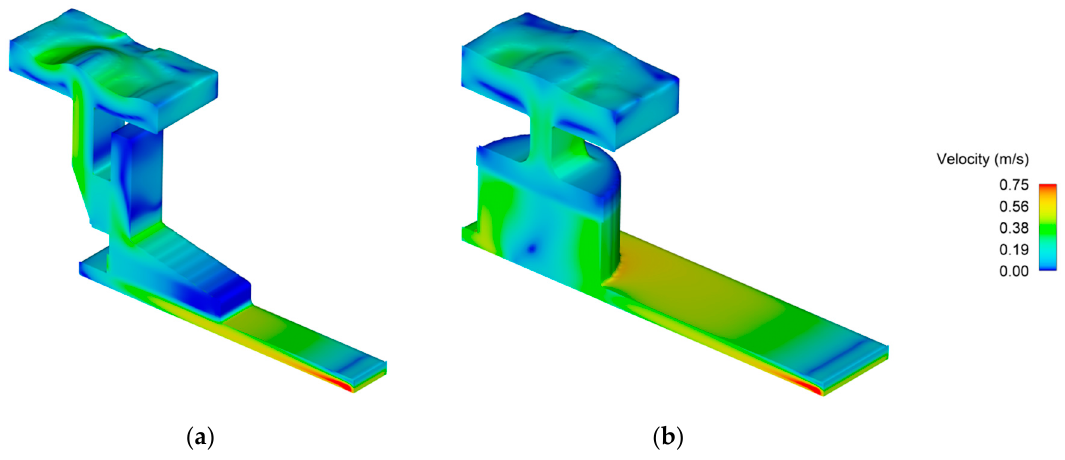
Figure 8. Velocity profiles for the ( a ) trident gate (TG) and ( b ) vortex gate (VG) systems.